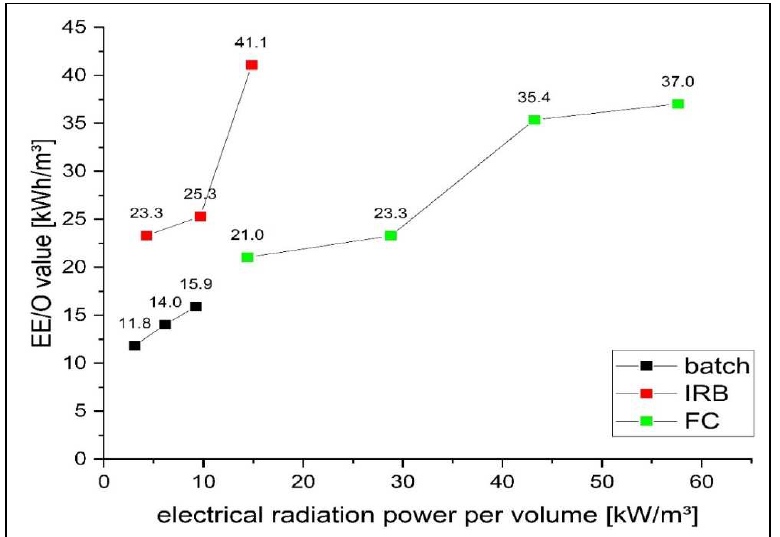
Figure 9. Mean EE/O values for the degradation of all eight micro-pollutants within the batch, flat cell, and immersion rotary body reactor as a function of the electrical irradiation per surface area (all mean values without carbamazepine).